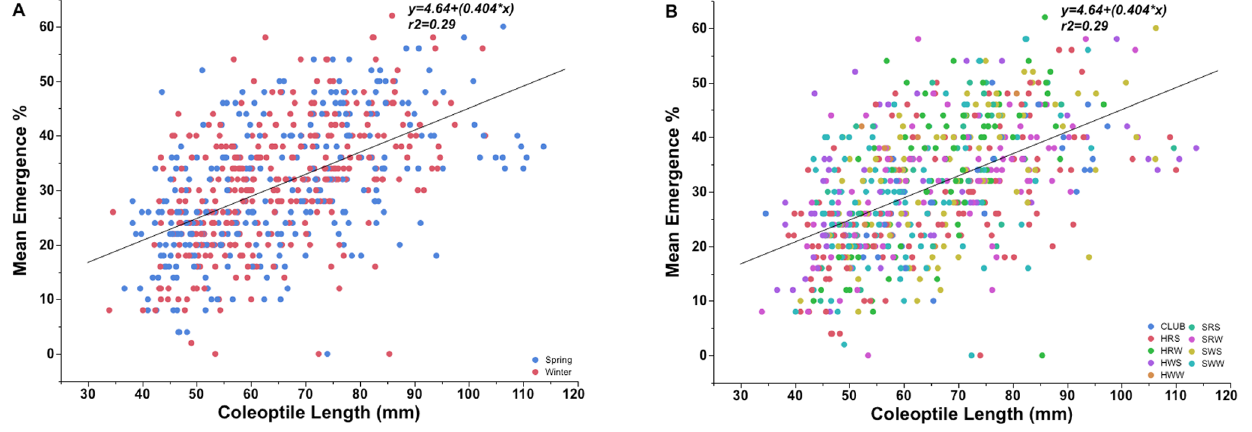
Figure 3. Mean emergence percentage of the (A) spring and winter type and (B) different market class of wheat world collection entries plotted against coleoptile length on 15 days after planting.